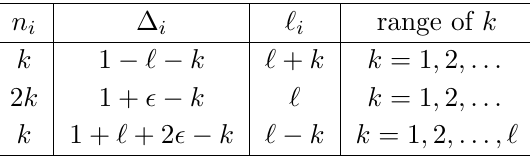
Table 5 . Three families of degenerate primaries that can appear in the OPE of two scalars, labeled by their scaling dimension (cid:1) i , spin ‘ i , and level n i of the (cid:12)rst null descendant. which satisfy the orthogonality